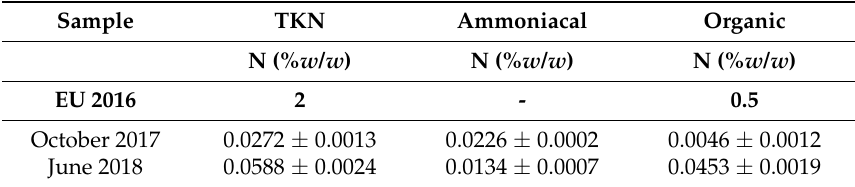
Table 3. Concentration of total, ammoniacal and organic nitrogen.